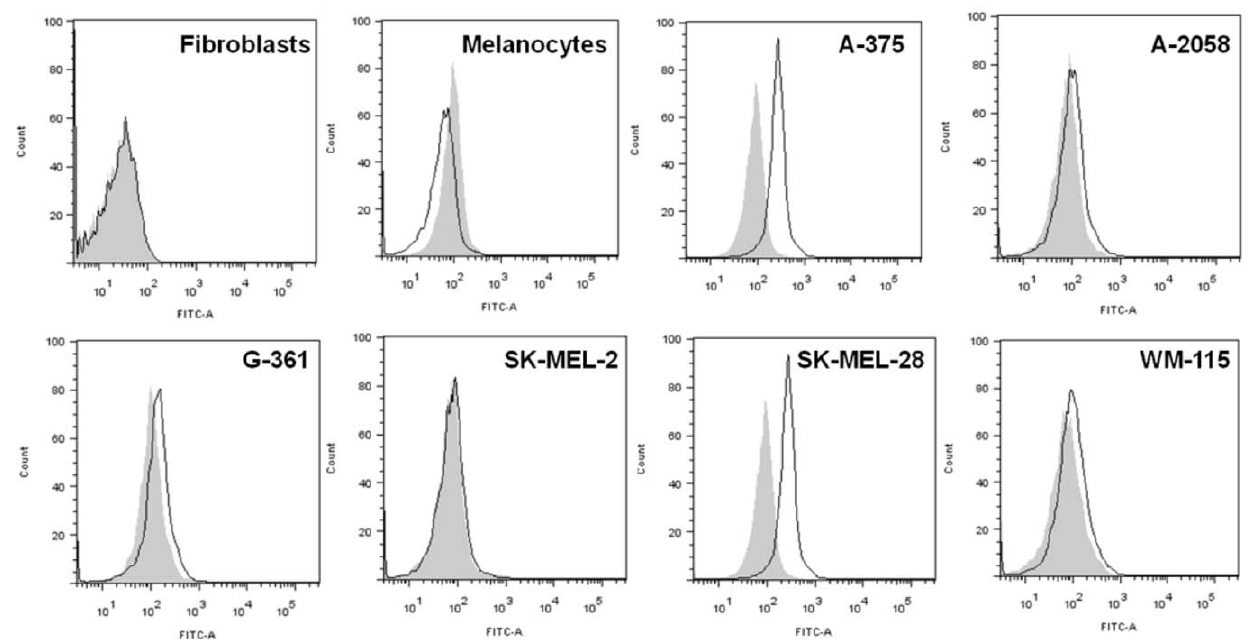
Figure 6. Selection of a patient derived B antibody that recognizes melanoma cells but not melanocytes. A selected tumor-reactive culture from a stage III patient (Patient 6) which secreted antibodies that bound to tumor cell lines and compared to melanocytes by ELISA (Figure 5, C) was sub-cloned, and a monoclonal antibody 6_2G3 was selected and evaluated on live cells by flow cytometry (solid black line histograms) for reactivity to fibroblasts, melanocytes, and 6 melanoma cell lines. IgG isotype controls are shown in shaded grey histograms.